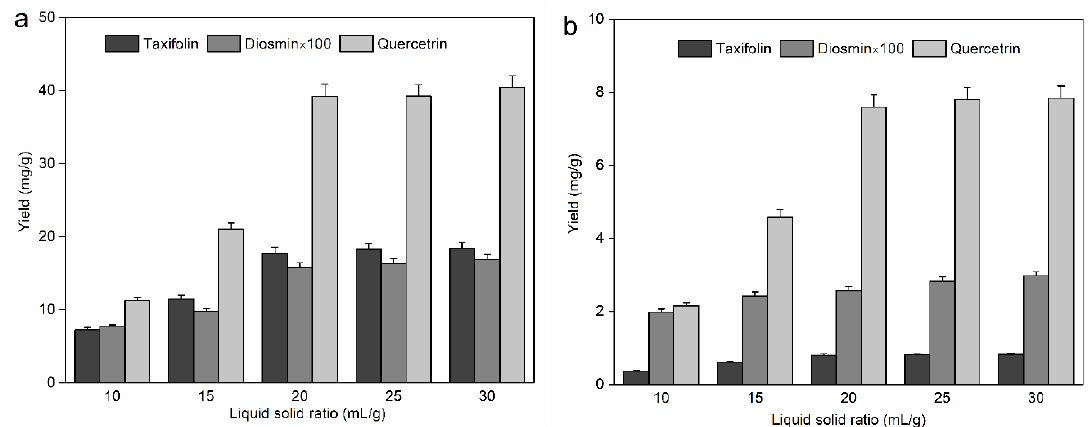
Figure 3. Effect of liquid–solid ratio on the yield of taxifolin, diosmin, and quercetin from Abies nephrolepis leaves ( a ) and bark ( b ).